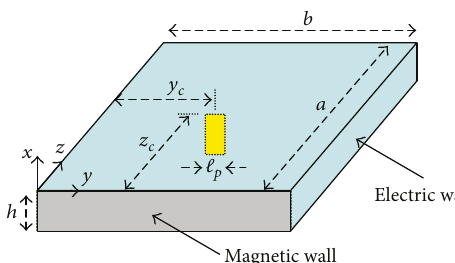
Figure 2: Equivalent cavity excited by a strip of uniform current